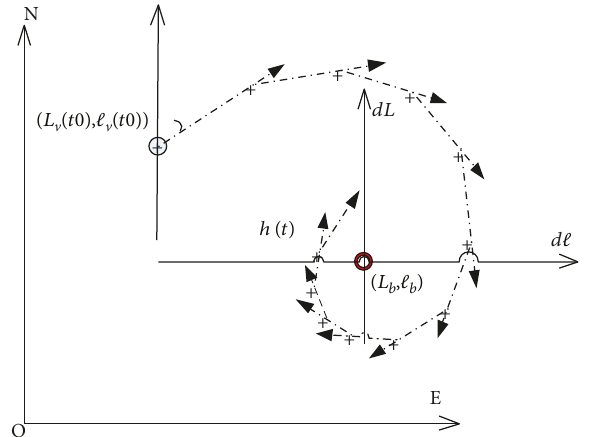
Figure 7: Spiral trajectory of the optimal circular maneuver range of approaching the single beacon.